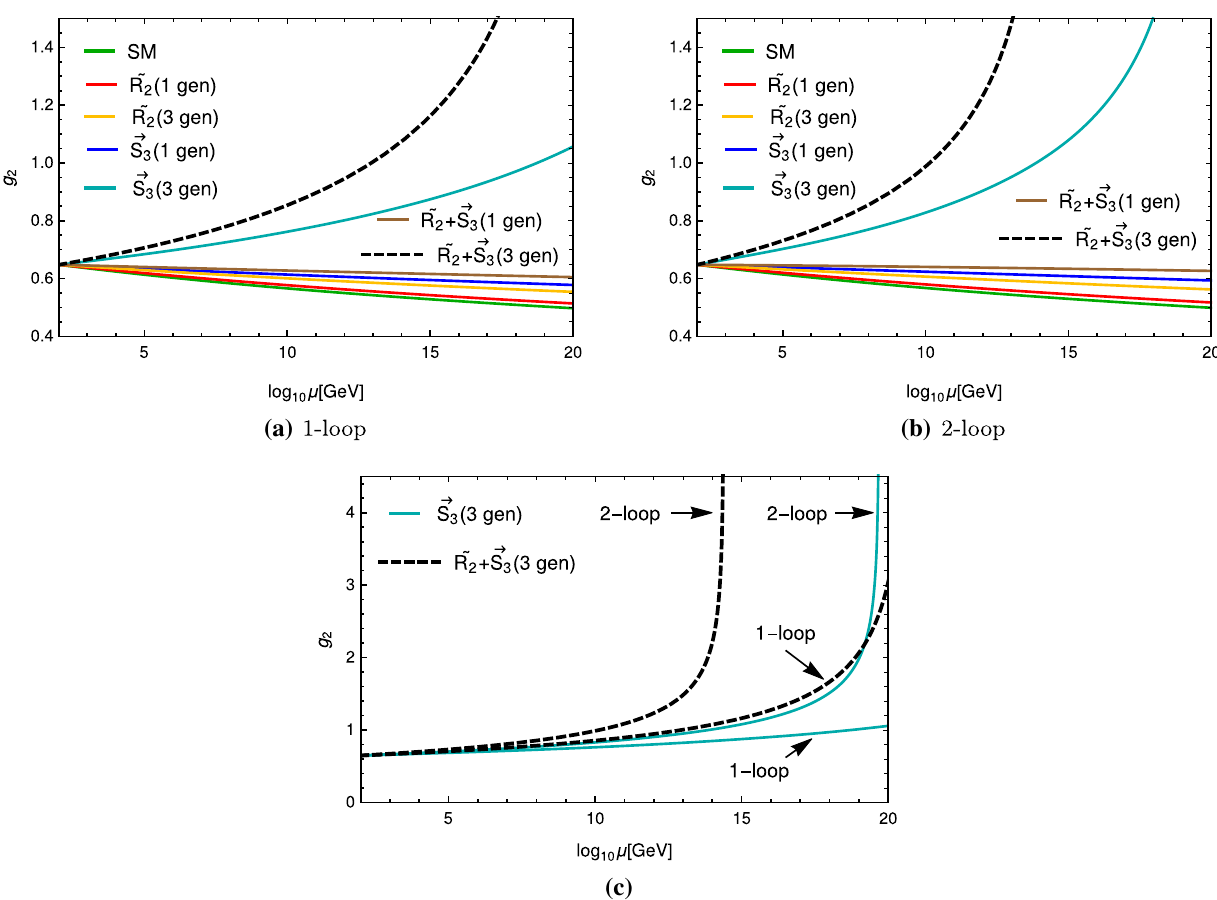
theblueandcyanlines,respectively;thebrownanddashedblackcurves illustrate the SM extension with one and three generations of both (cid:2) R 2 and S 3 , respectively. The initial values for the SM parameters are listed in Table 1 along with Y φ = 0 .